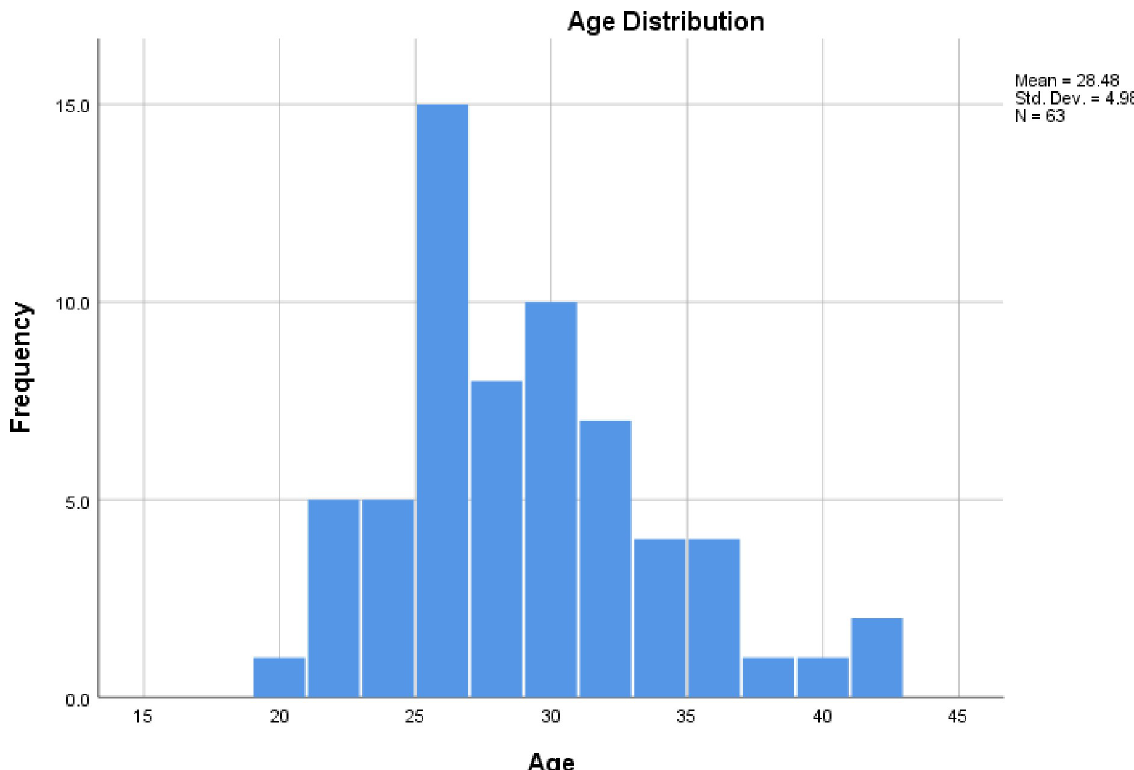
Fig 1. The age distribution of our sample population.